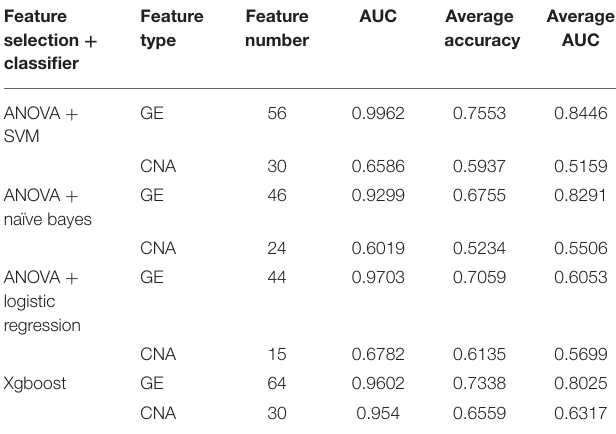
TABLE 1 | Performance of four classifiers using the training dataset.